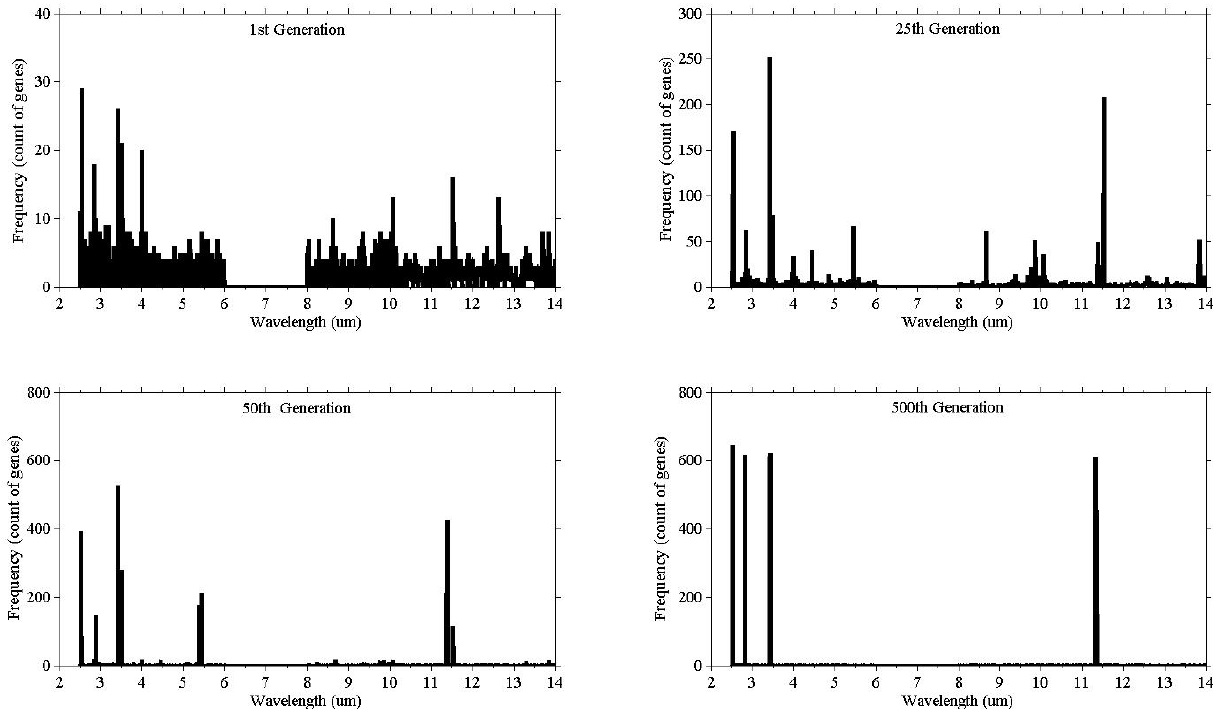
Figure 3. The graphical representation of gene convergence, the frequency (count of genes selected in the population) clustered around certain wavebands as the number of generations